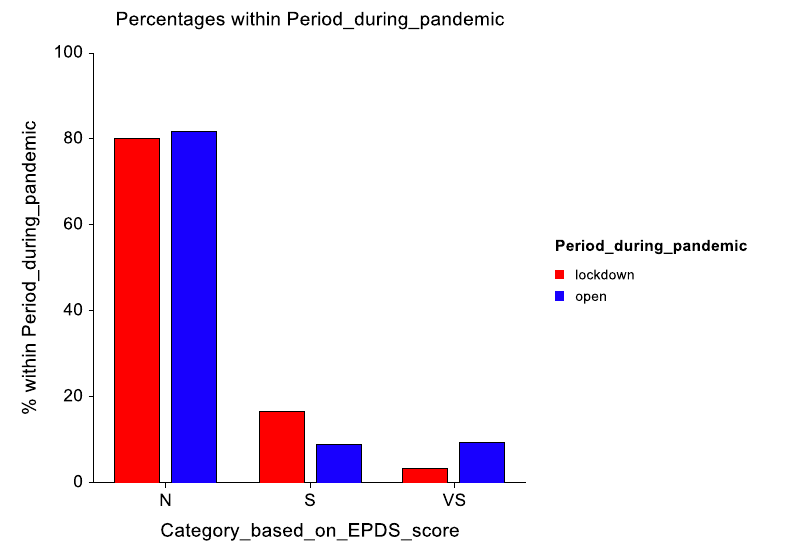
Figure 2. Distribution of patients based on EPDS scores and preestablished cut-off values.